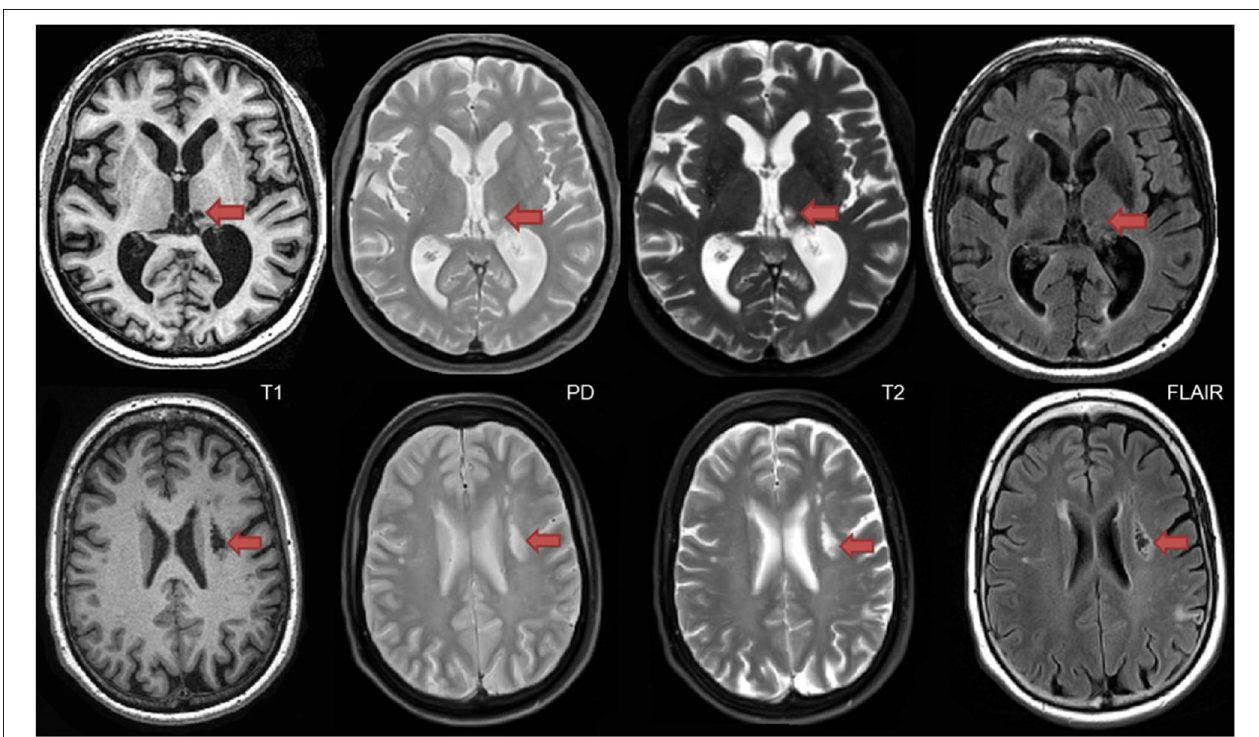
FIGURE 9 | Top row shows a thalamic lacune as it appears on different coregistered MRI, hypointense (dark) on T1, hyperintense on PD-T2, and difficult to detect on FLAIR. In contrast, the bottom row shows a subcortical lacunar infarct that presents with the classic central CSF-like hypointensity with a surrounding hyperintense halo/rim on